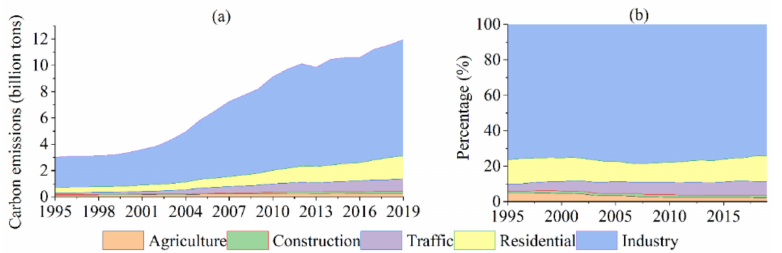
Figure 1. Trends in CEs from 1995 to 2019. ( a ) carbon emissions of China from 1995 to 2019; ( b ) carbon emission percentages of five sectors of